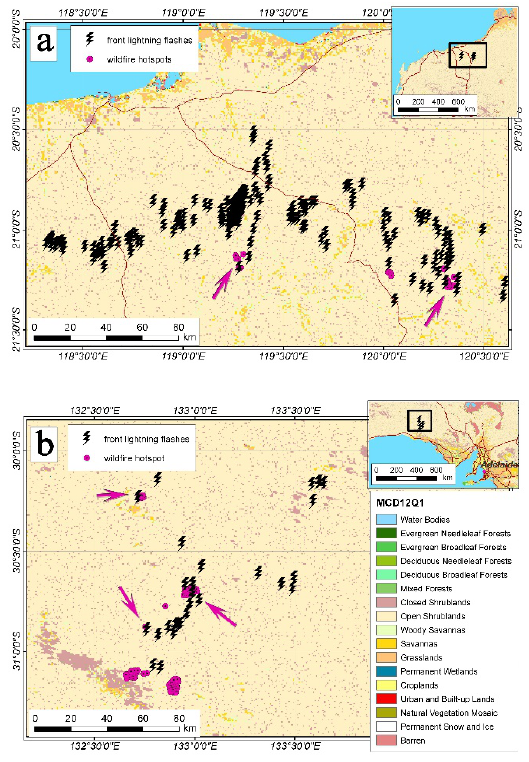
Figure 13. The lightning wildfires on 21 October 2019 (2 events) and on 29 December 2019 (3 events) are illustrated by multiple ignitions of the thunderstorm front in ( a , b ), accordingly. The lightning-caused wildfires in both study cases happened at the same time, but were separated by tens of kilometers. Thus, when the dry period changes to a wet one, a special condition may be created in which strong thunderstorms can lead to numerous fires. It occurs because, firstly, during this period, the thunderstorm strikes are already strong enough, and secondly, the underlying surface layer remains dry from the previous dry period.